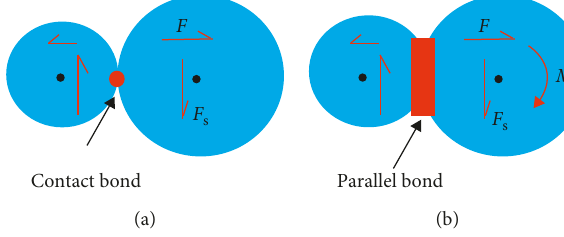
Figure 8: BPM of the particle flow code [17].